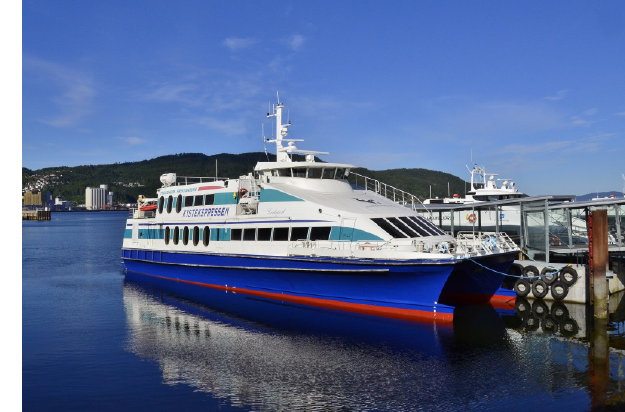
Figure 5: The passenger ship MS LADEJARL (gross tonnage 490 t, length 38 m, breadth 10